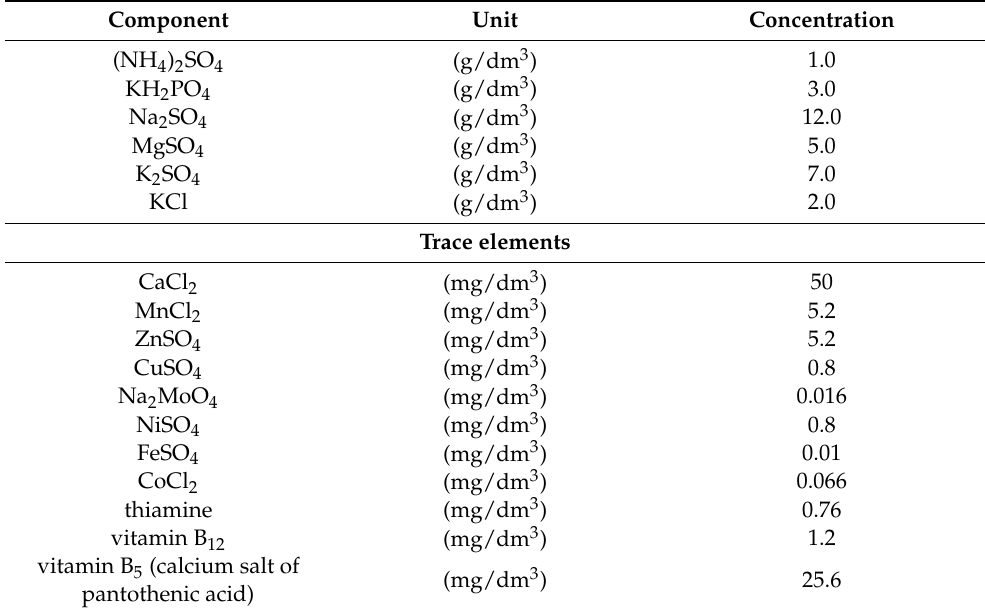
Table 2. Profile of artificial